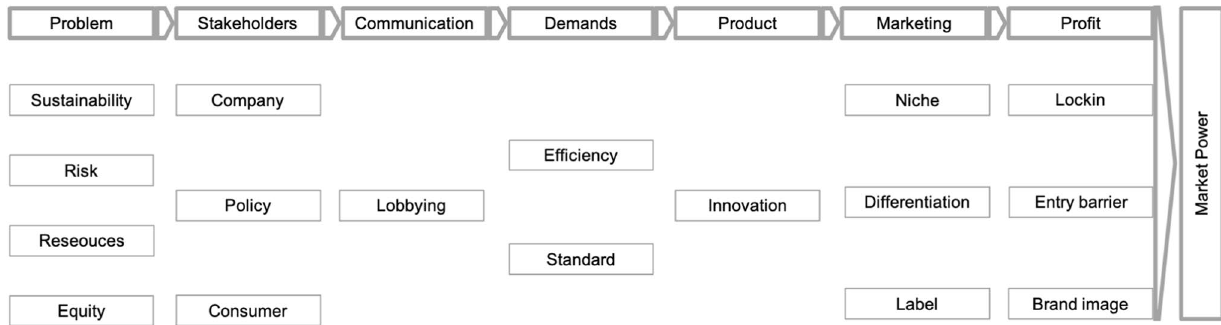
Fig. 1 Sustainability triggers market power. From recognizing a specific sustainability problem to demanding product improvements, to marketing the improved product, to generating above-average